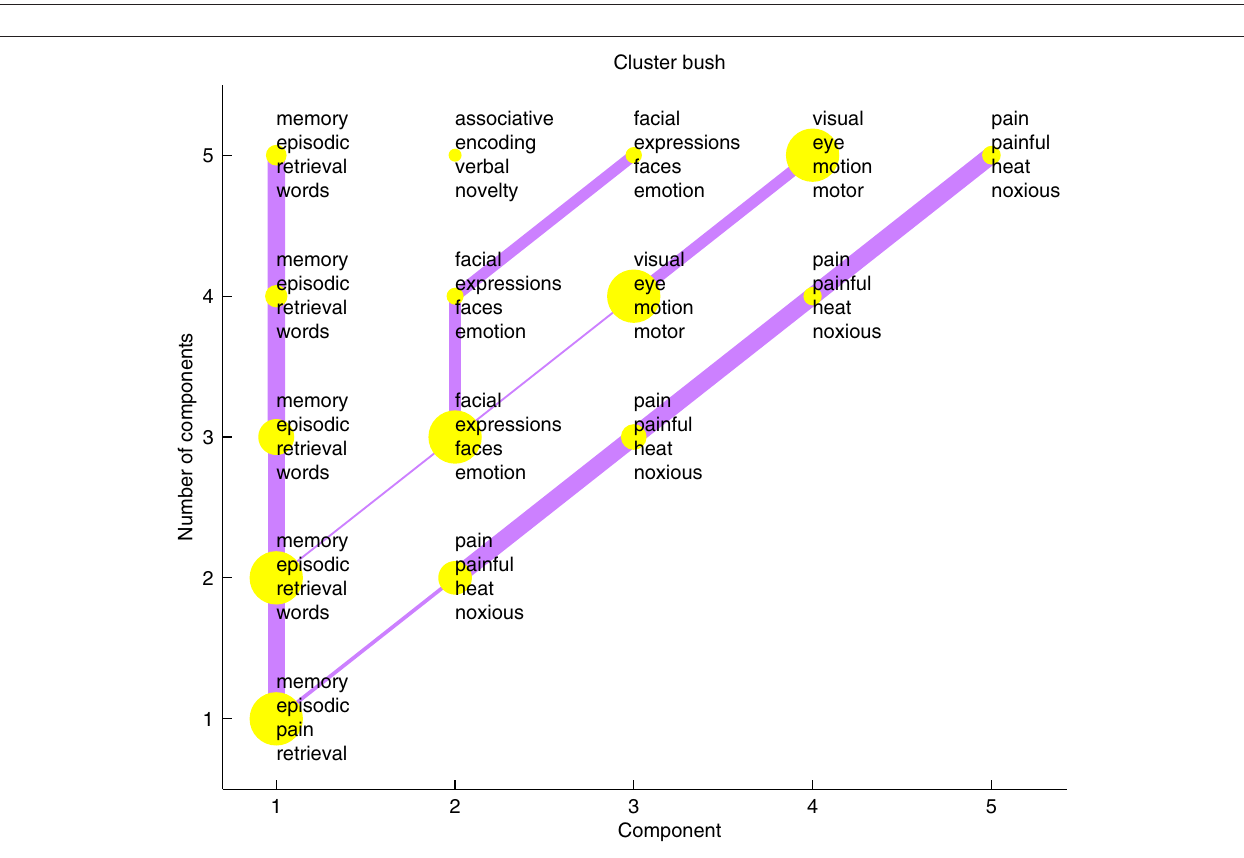
FIGURE 9 | A so-called ‘cluster bush’ visualization of the text mining results of the abstracts in the Brede Database. Each yellow dot is a cluster of articles and words in the article. The four words with highest load on each cluster are